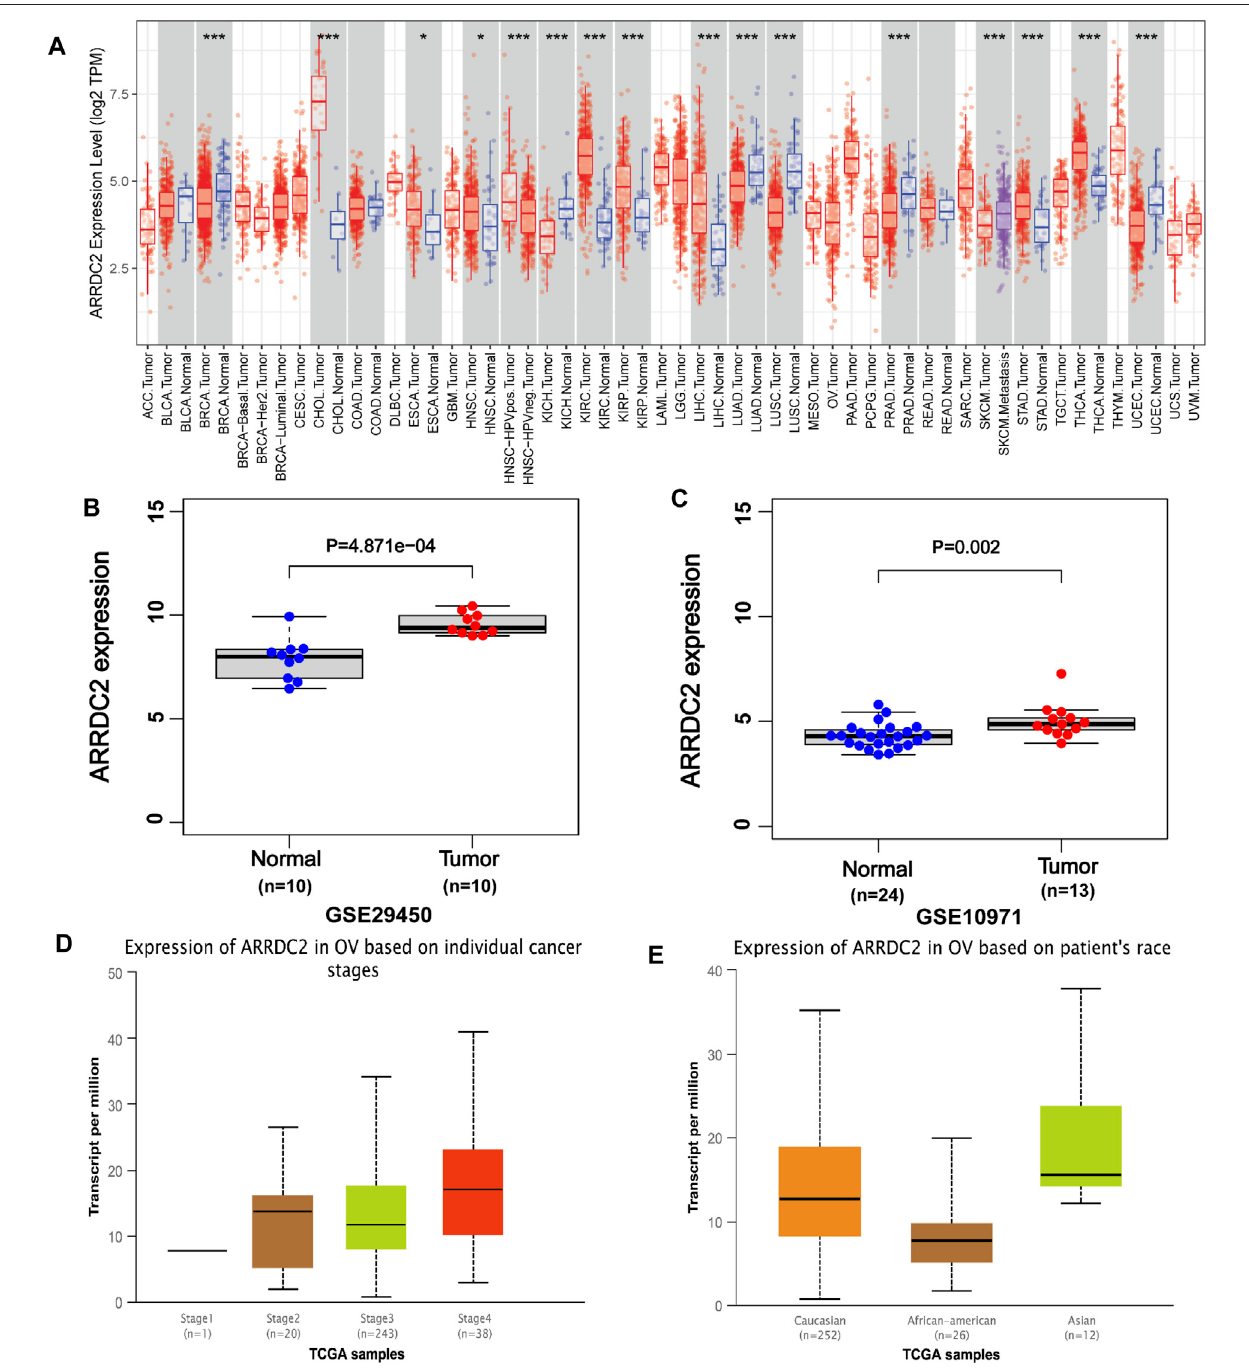
FIGURE 1 | The expression of ARRDC2 (mRNA, gene microarray and gene sequencing) in OVs. (A) Expression of ARRDC2 in pan-cancer. (B) Box plot based on the expression level of ARRDC2 in the GSE29450 (OV = 10, Normal = 10). (C) Box plot based on the expression level of ARRDC2 in the GSE10971 (OV = 13, Normal = 24). (D) The expression level of ARRDC2 in OV based on individual FIGO stage. (E) The expression level of ARRDC2 in OV based on the race of